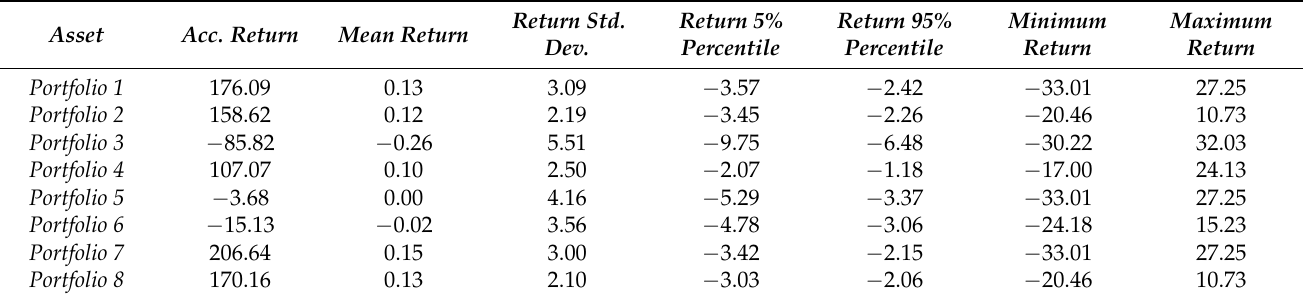
Table 4. Performance of the 8 simulated portfolios for a theoretical investor that pays no stock trading fees and only future trading roll-over costs.